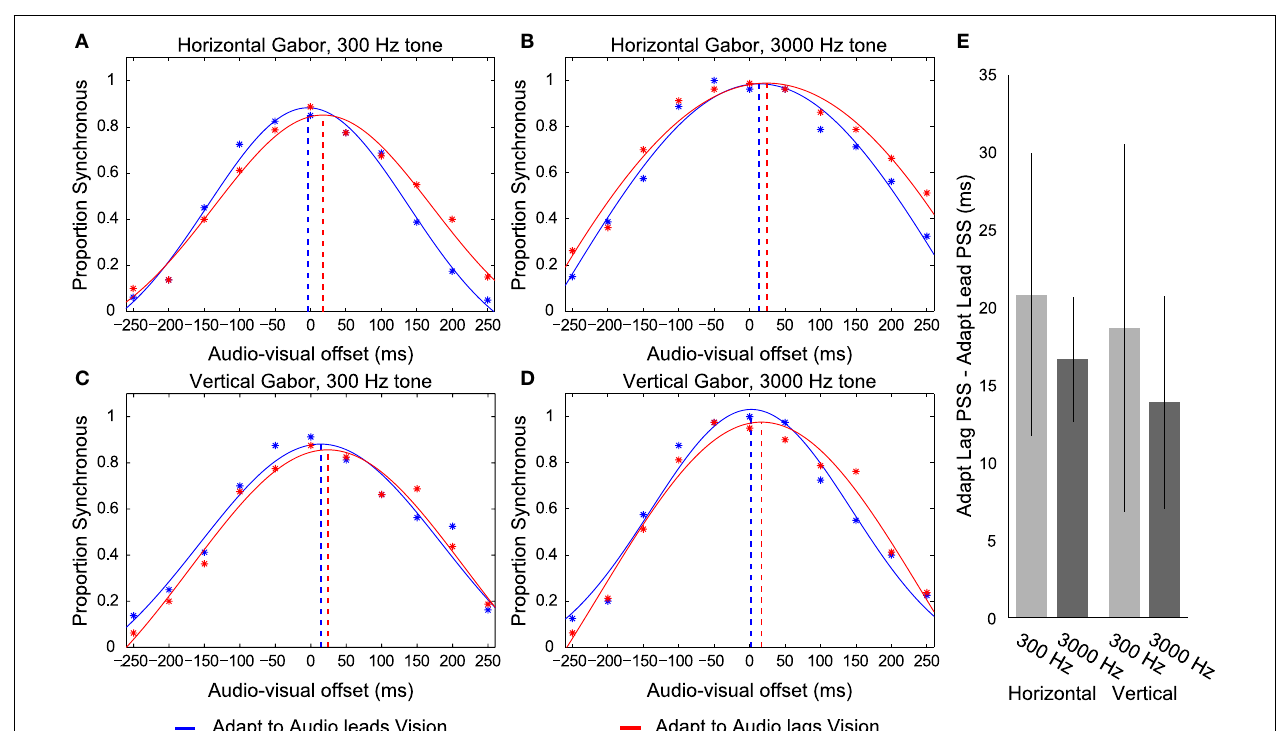
Adapt to Audio lagsVision refers to the reverse case, where the exposed timing relationship during adaptation was such that audition was presented following vision by 150ms. Note that participants concurrently adapted to opposite audio-visual timing relationships for each stimulus during a given set of trials such that, for example, they adapted to audio leads vision for the Horizontal Gabor and 300Hz tone combination while concurrently adapting to audio lags vision for theVertical Gabor and 3000Hz combination. (E) Difference in PSS between adapting to an audio leading vision compared to audio lagging vision relationship for each stimulus, for each participant, averaged across the eight participants. Error bars indicate ± 1